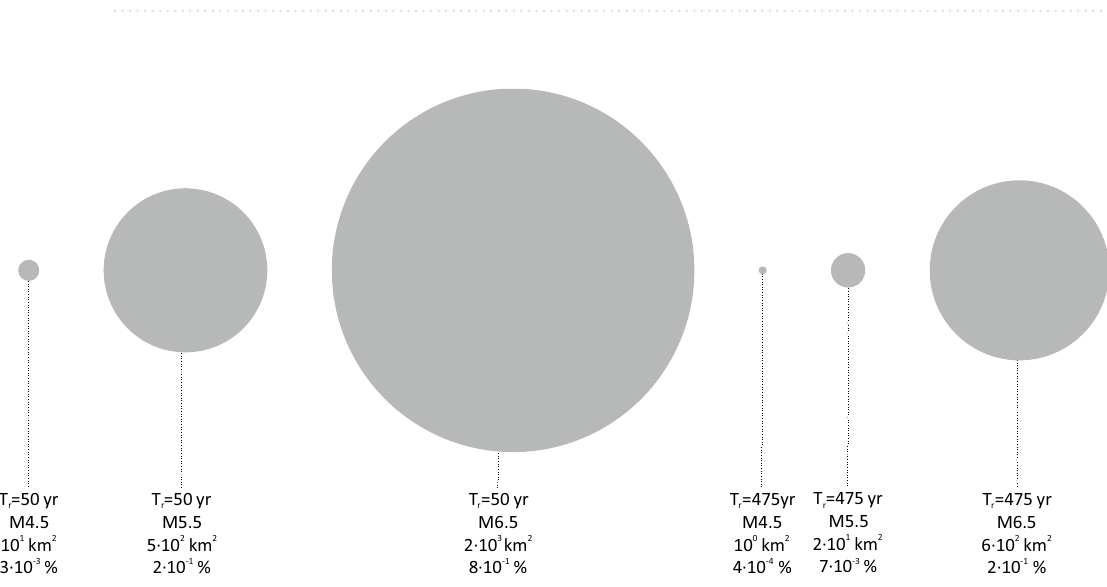
Figure 4. Exceedance area for structural design seismic action in terms of PGA with 50 and 475 years return period as per the models fitted in this study when magnitude is equal to 4.5, 5.5, and